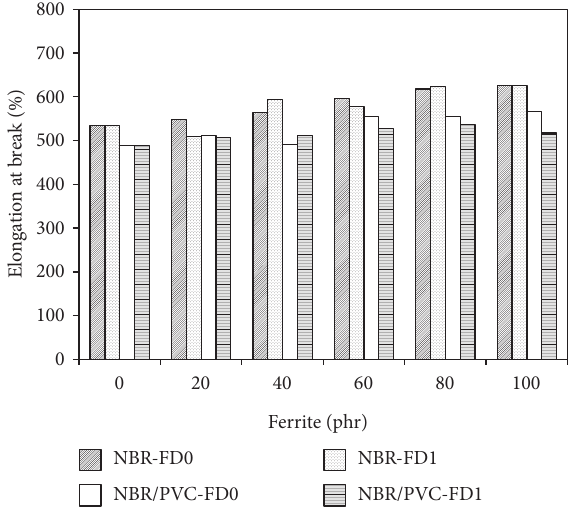
Figure 7: Influence of ferrites content on modulus M100 of com- posites.